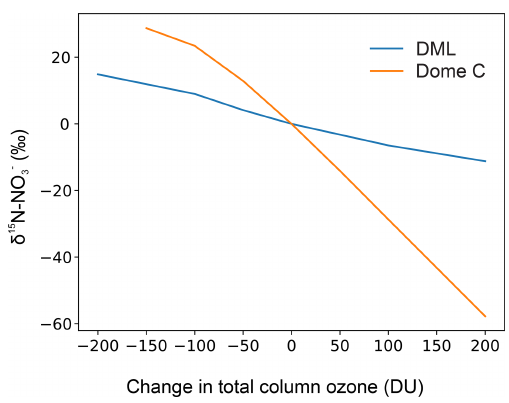
Figure 8. Expected response of archived δ 15 N-NO − total column ozone at Dronning Maud Land (DML) and Dome C. Calculated sensitives represent an upper range as the real ozone hole lasts from September to November before recovery and not as mod- elled using the entire sunlit season. Archived DML δ 15 N-NO − ues were simulated using the observed accumulation rate, e -folding depth of 5cm (5cm EFD case), and present-day TCO values. These TCO values, which were used in all our calculations, vary weekly and can be found in Table S4. For each week, a constant amount of ozone (e.g. 100DU) was added or subtracted from these present- day values. Dome C data source: Erbland et al.